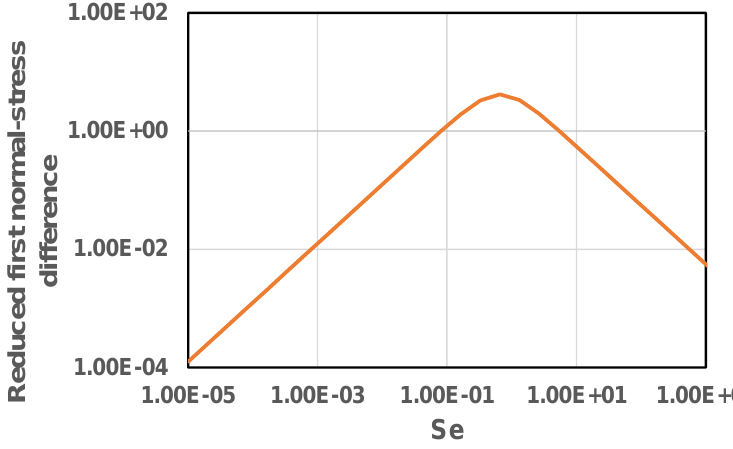
Figure 14. Reduced first normal-stress difference N 1 r / φ as a function of Se for suspensions of soft-solid particles. Fluids 2016 , 1 , 40